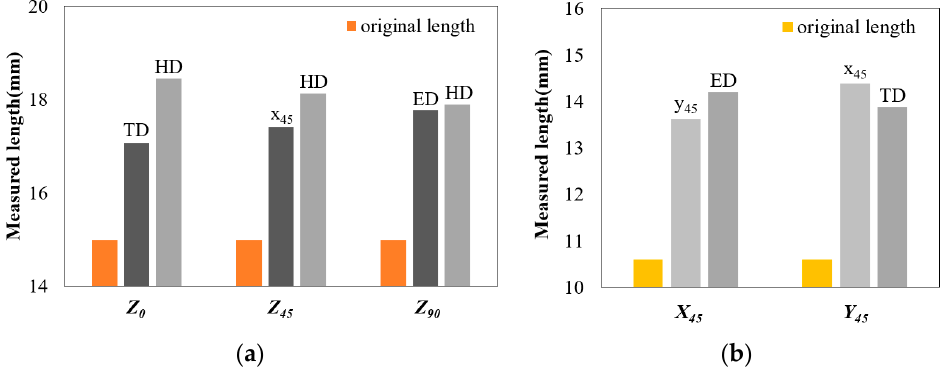
Figure 8. Comparisons of measured lengths of compressed cube specimens: ( a ) 15 mm cube, ( b ) 10.6 mm cube.